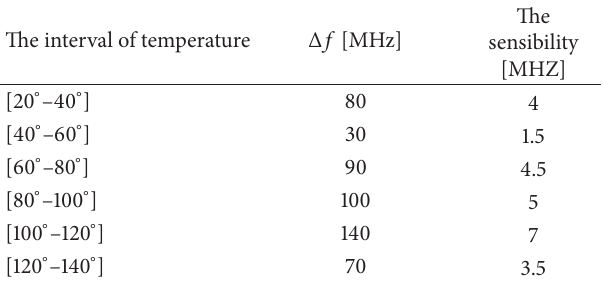
The interval of temperature Δ𝑓 [MHz]